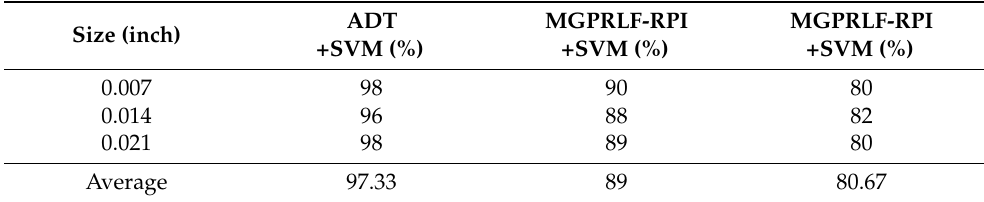
Table 6. The average accuracies of the roller crack size identification using the ADT+SVM, MGPRLF- RPI+SVM, and MGPRLF-PI+SVM techniques.